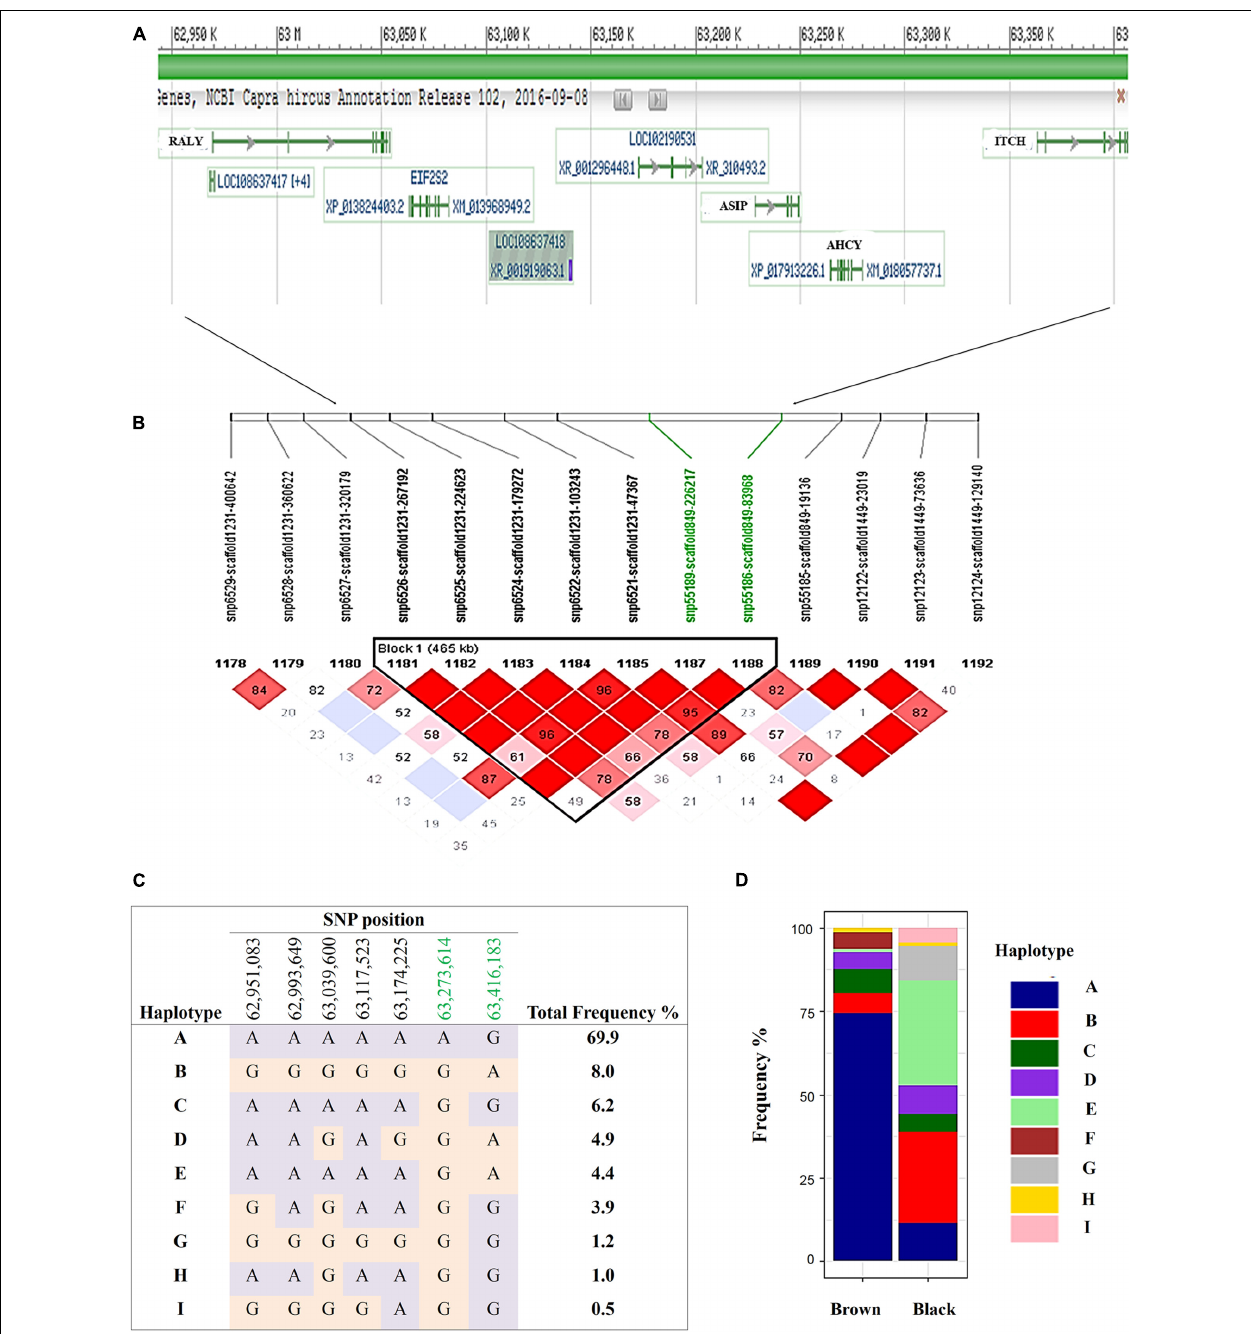
FIGURE 4 | Haplotypes within a single 465 Kb LD block on chromosome 13 for brown and black coat color. (A) Genes incorporated in the (B) 465 Kb LD block (C) defined 9 haplotypes within the sampled Markhoz goat population and (D) the frequency of the haplotypes in black and brown goats. Gene track images are from NCBI Genome Data Viewer (https://www.ncbi.nlm.nih.gov/genome/gdv/browser/?acc=GCF_001704415.1&context=genome), accessed 10/11/2017).